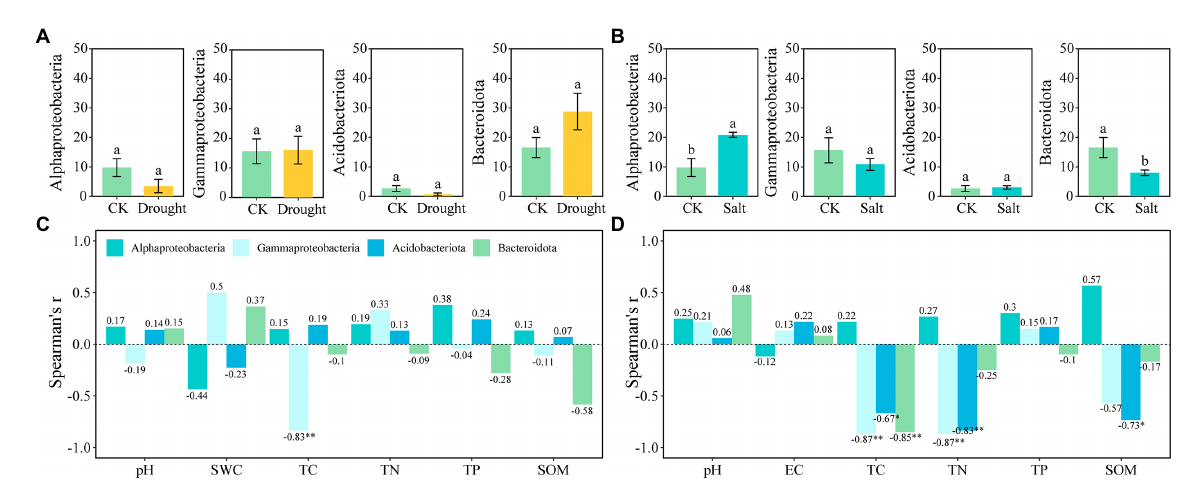
FIGURE 3 The relative abundance of bacteria for r-and k-strategists (A,B) and the correlation with rhizosphere soil properties of N . tangutorum under different stress (C,D) . Drought: A and C ; Salt: B and D . “*” represents p < 0.05, “**” represents p < 0.01, and “***” represents p <